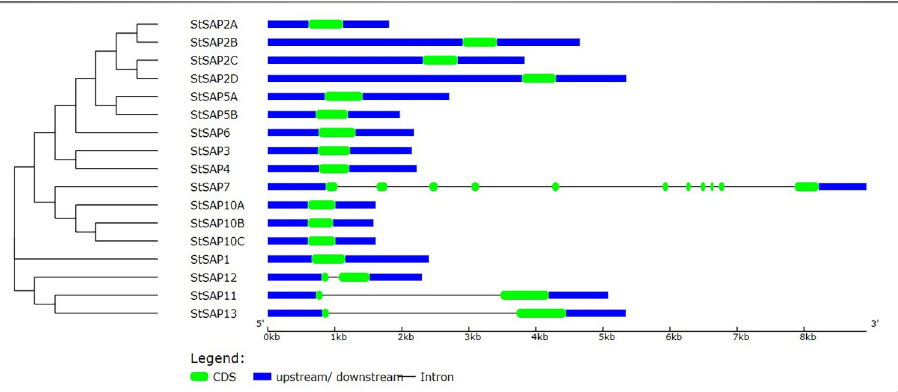
Fig 3. The distribution of exon-intron in the structure of StSAP genes according to the phylogenetic relationship.